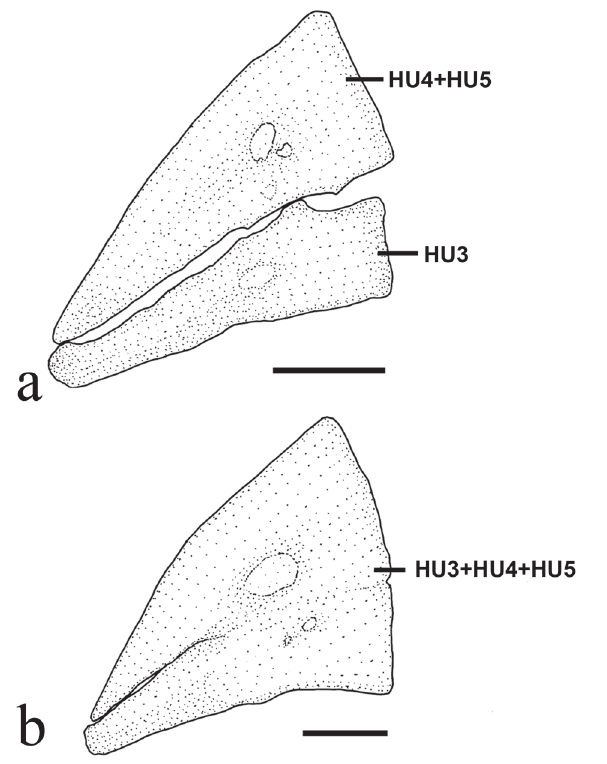
Fig. 7. Upper caudal plates of Trichomycterus balios , lateral view, anterior to left. (a ) = paratype, MCP 41292, 64.7 mm SL; ( b ) paratype, MCP 41292, 72.3 mm SL. Abbreviations: HU3, hypural 3; HU4+HU5, complex plate formed by co-ossification of hypurals 4 and 5; HU3+HU4+HU5, complex plate formed by co-ossification of hypurals 3, 4 and 5. Scale bar = 0.5